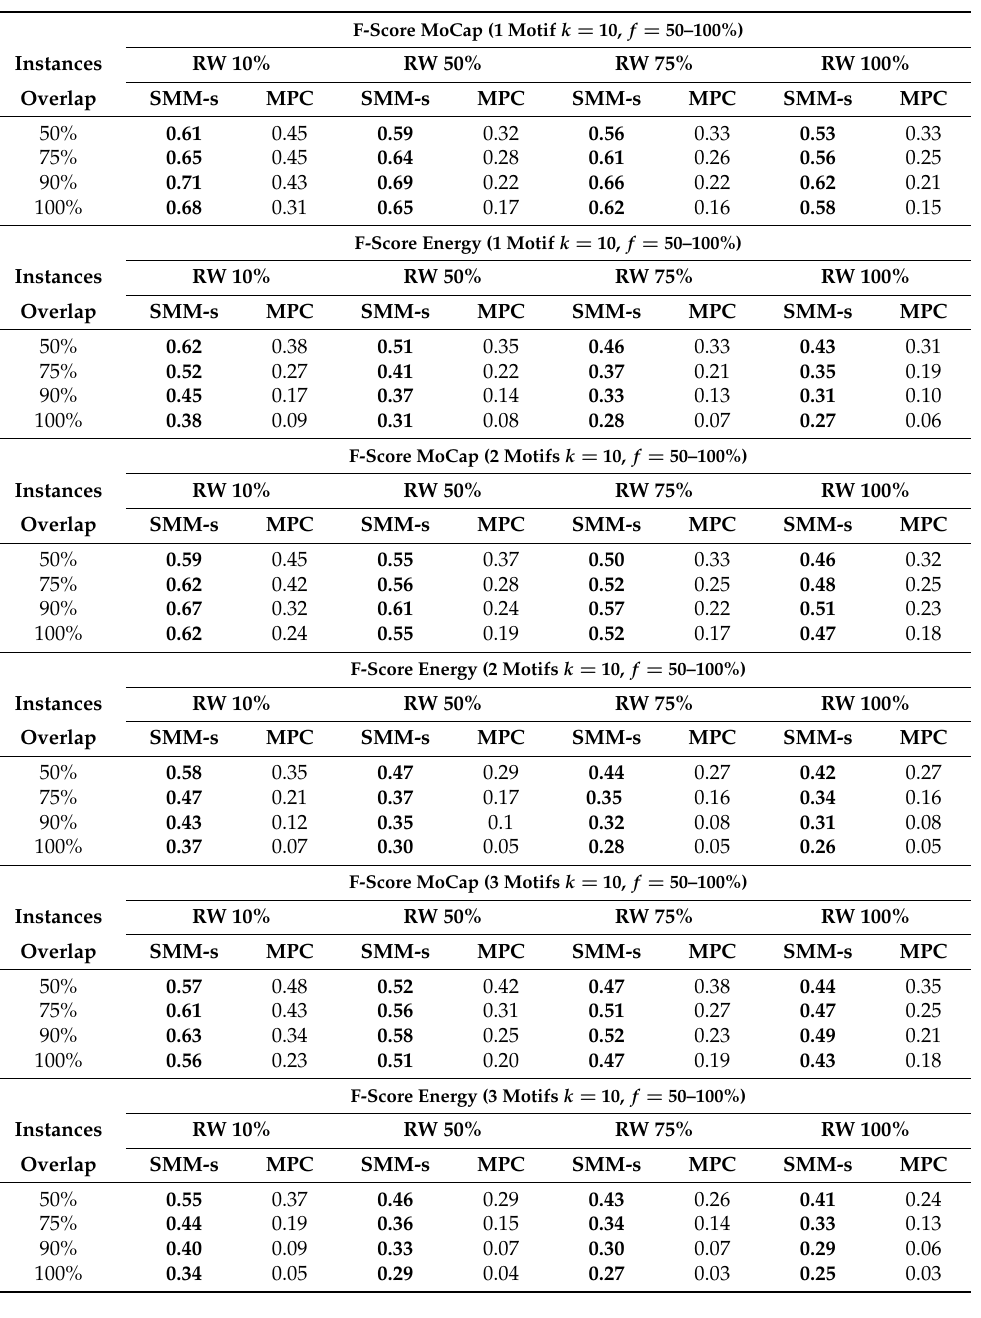
Table 4. F-scores for time series with one motif (M1), for varying target overlaps considering multiple scales of random walk (default